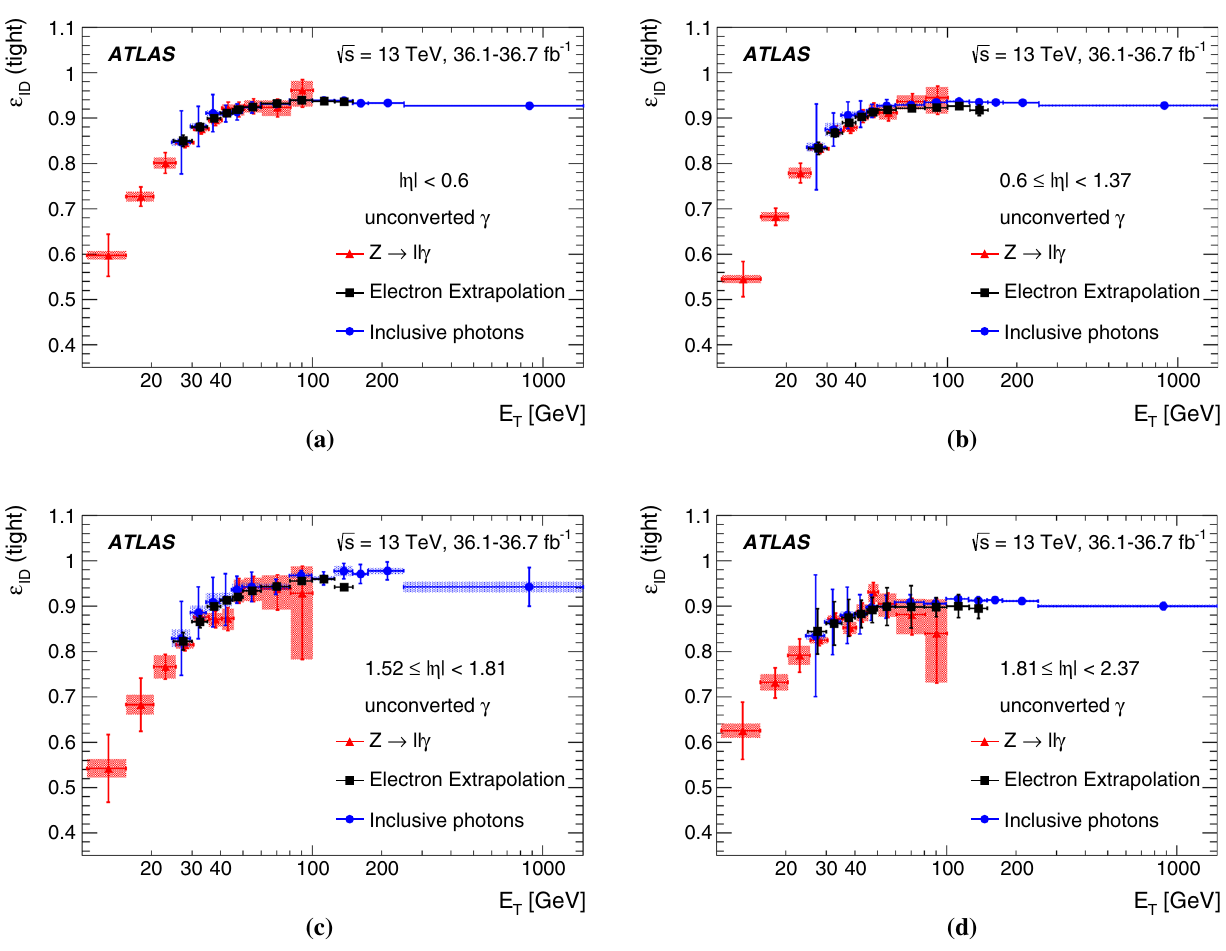
Fig. 7 Comparison of the data-driven measurements of the identifi- cation efficiency for unconverted photons as a function of E T , for the four pseudorapidity intervals a | η | < 0 . 6, b 0 . 6 ≤ | η | < 1 . 37, c 1 . 52 ≤ | η | < 1 . 81, and d 1 . 81 ≤ | η | < 2 . 37. The error bars represent